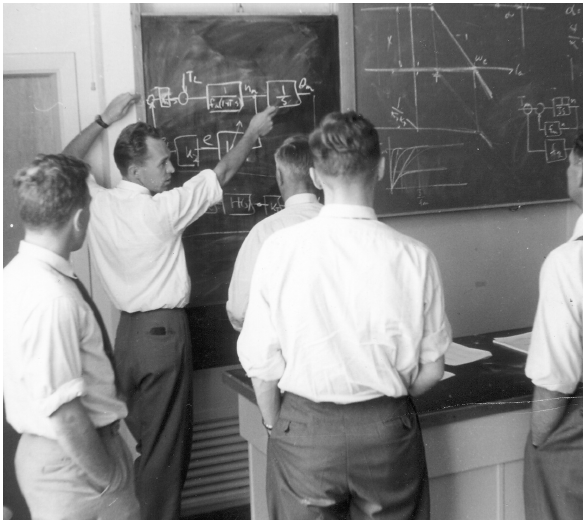
Figure 5: Jens lecturing on block diagrams in